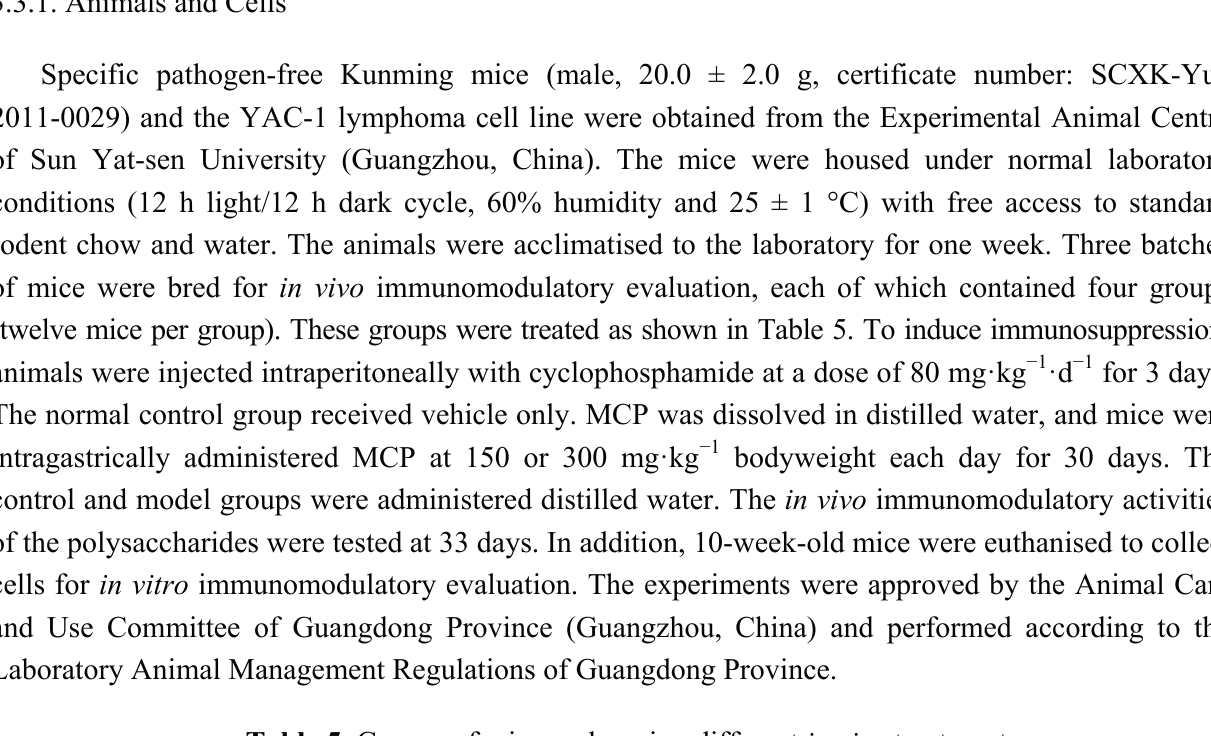
Table 5. Groups of mice undergoing different in vivo